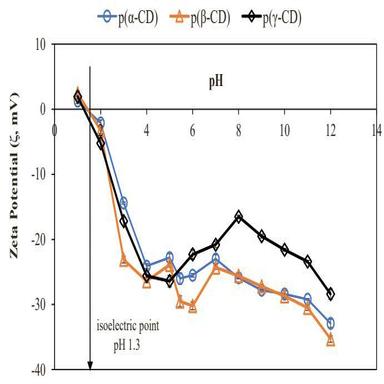
The change in zeta potential (ζ, mV) values with solution pH of p(α-CD), p(β-CD), and p(γ-CD) particles.